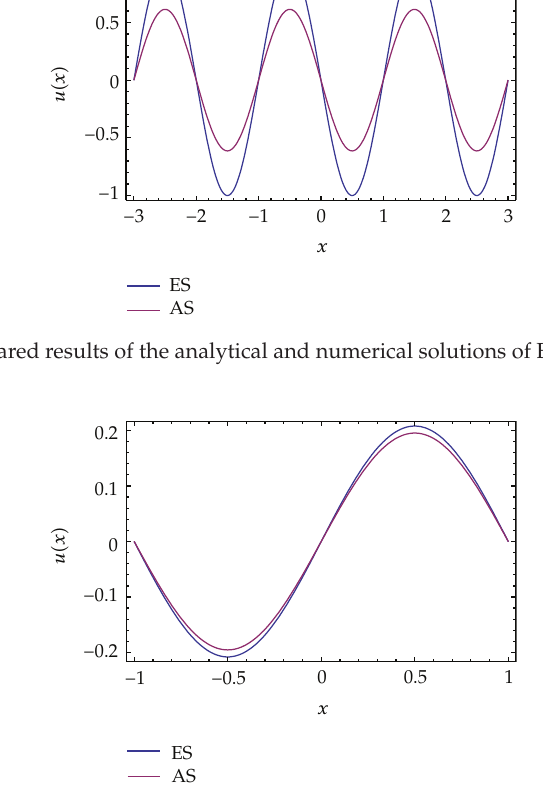
Figure 4: The compared results of the analytical and numerical solutions of Example 4.2 for t (cid:3) 0 .